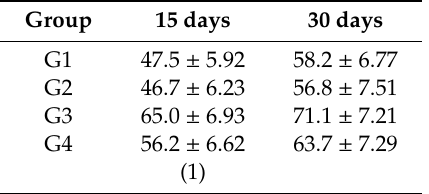
Table 7. Table data (mean, standard deviation, and median) and graph values distribution of the bone-to-implant contact percentage (BIC%) measured around the surface of each sample.